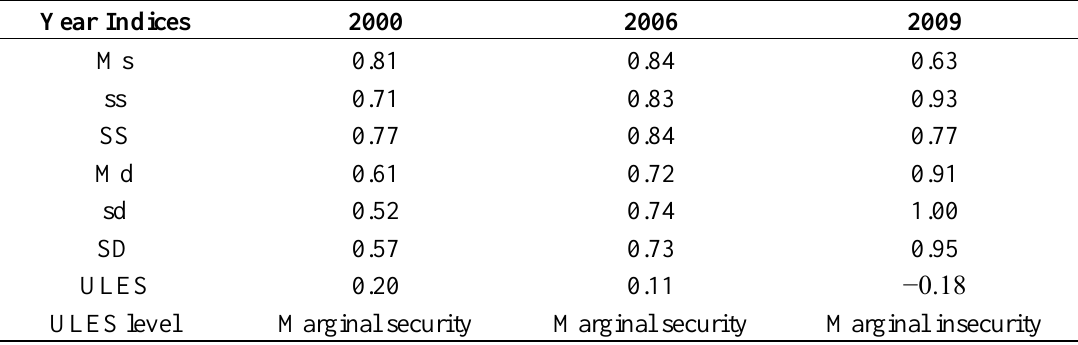
Table 5. Regional supply and demand index of land ecological security in